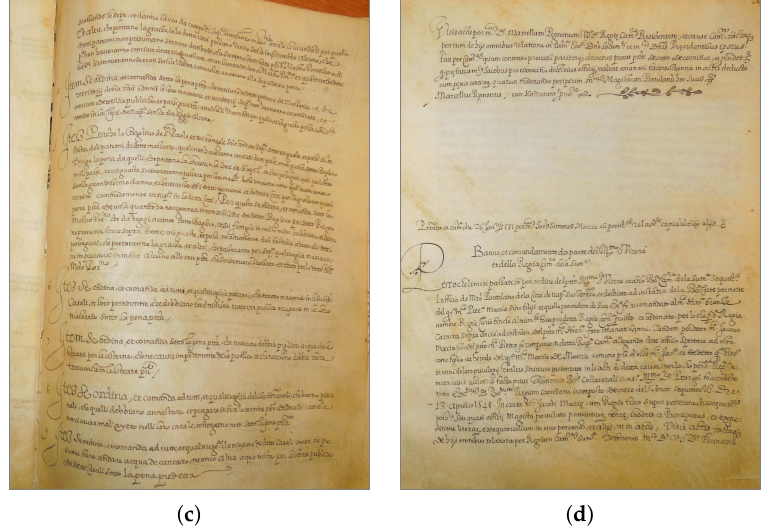
Figure 1. Examples of pages from the Moccia Code: ( a ) f. 6r; ( b ) f. 7v; ( c ) f. 9r; ( d ) f. 10r.